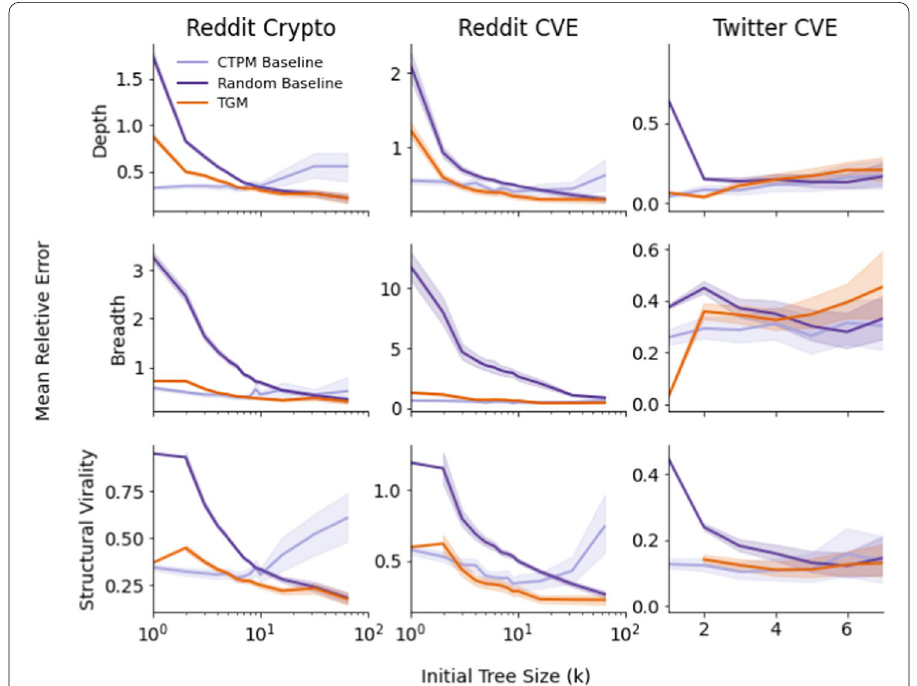
Fig. 8 Mean Relative Error of whole‑tree metrics (depth, breath, and structural virality) versus initial size k . For the Twitter CVE dataset, TGM predicts all trees to have size one when k = 1 , so that the structural virality is